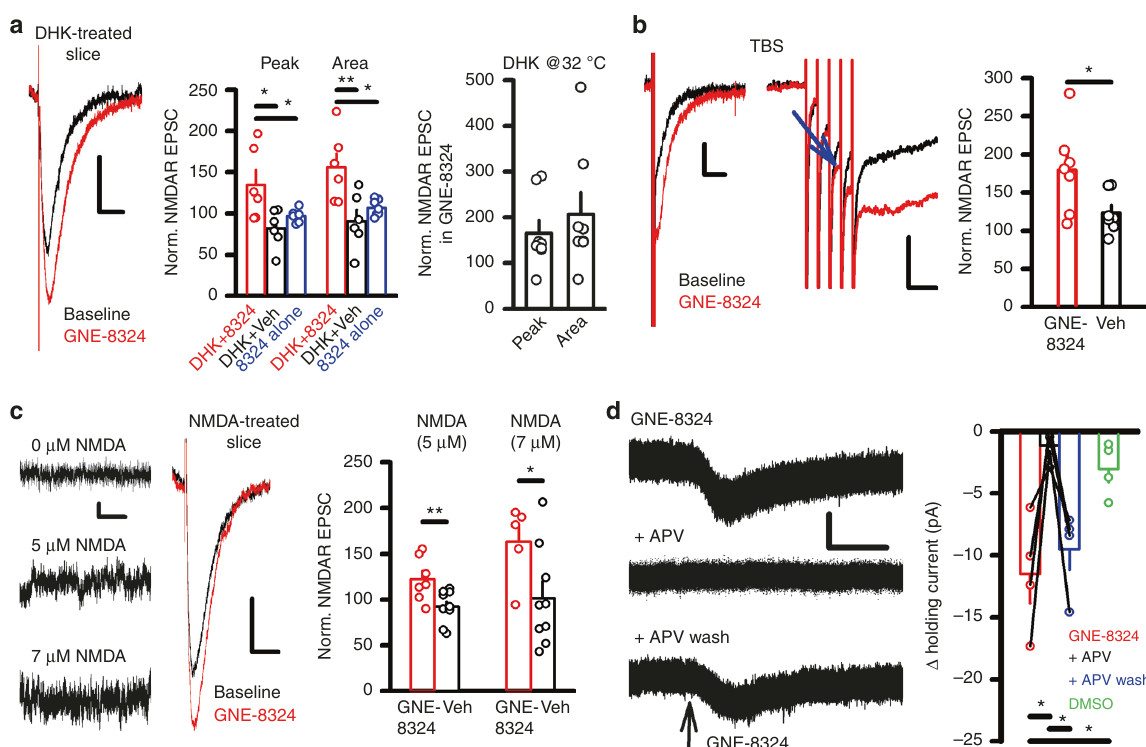
Fig. 5 Increasing ambient synaptic glutamate level in the excitatory neurons enables GNE-8324 potentiation of NMDAR EPSCs. a Bath application of the GLT-1 inhibitor DHK revealed signi fi cant potentiation of NMDAR EPSCs in the excitatory neurons. Sample traces of NMDAR EPSCs before and after GNE- 8324 in the presence of DHK. Scale bars, 10 pA/100 ms. GNE-8324 potentiation was only observed in excitatory neurons following DHK treatment. * P (peak) < 0.05; ** P (area) < 0.01, one-way ANOVA with Dunnett's correction, both compared to vehicle. Signi fi cant GNE-8324 potentiation was observed at 32 °C in the presence of DHK. b TBS in the excitatory neurons revealed signi fi cant GNE-8324 potentiation. (Left) Sample traces showing prominent GNE-8324 potentiation. (Right) Expanding the portion of EPSC traces around the TBS portion revealed increasingly larger baseline responses with successive TBS pulses (indicated by the arrow). Scale bars, 10 pA/100ms (left); 20 pA/10 ms (right). TBS-induced NMDAR EPSC areas were signi fi cantly enhanced by GNE-8324, compared to vehicle. * P < 0.05, unpaired t test. c Bath-applied NMDA enabled GNE-8324 potentiation in the excitatory neurons. Sample traces of holding current after bath application of 0, 5, or 7 μ M NMDA. Scale bars, 5 pA/100ms. Sample traces showing signi fi cant GNE-8324 potentiation in the excitatory neurons in the presence of 7 μ M NMDA. Scale bars, 10 pA/100ms. Quanti fi cation of GNE-8324 potentiation in the presence of NMDA. For 5 μ M NMDA, GEN-8324, 122.2 ± 9.05% (area); Veh, 92.33 ± 5.39 (area); ** P (area) < 0.01; N = 10 (GNE-8324) and N = 7 (Veh). For 7 μ M NMDA, GNE-8324, 163.3 ± 18.53% (area), 101.6 ± 17.94% (area); * P (area) < 0.05; N = 9 (GNE-8324) and N = 5 (Veh), unpaired t test. d GNE-8324 potentiated NMDAR responses in excitatory neurons in the absence of synaptic stimulation. Sample traces. Puf fi ng of GNE-8324 (3 mM) is indicated by the arrow. Scale bars, 10 pA/1 s. Quanti fi cation of responses to puf fi ng of GNE-8324. N = 4 (GNE-8324), 4 (DMSO), 4 (GNE-8324 in APV), and 4 (GNE- 8324 after APV washout). ** P < 0.01, paired t test. The same neurons are connected by lines. Error bars represent